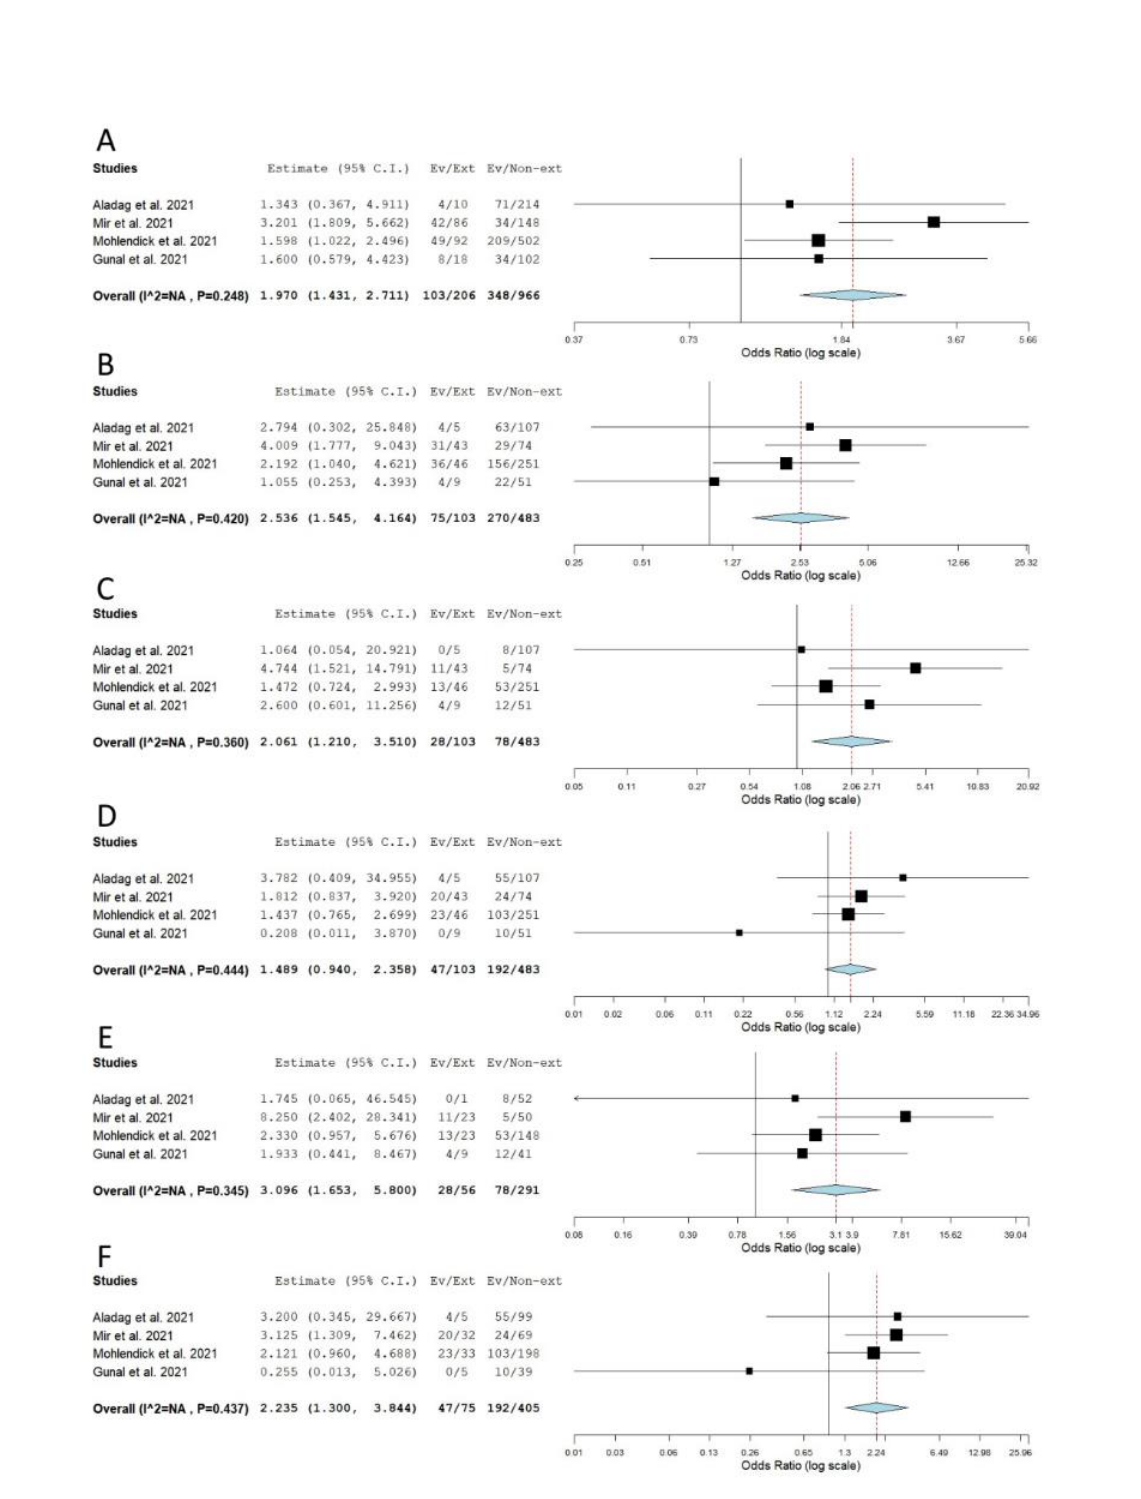
Figure 4: Meta-analysis of the association between rs1799752 in ACE1 and COVID-19 outcome: comparison exitus vs. survivors. A ) allelic model; B ) dominant model; C ) recessive model; D ) over- dominant model; E ) II vs. DD; F ) DI vs. DD. The results of the included studies presented as ORs, with 95 % CI, and the overall effect with 95 % CI are shown in the forest plot. P values given are derived from heterogeneity